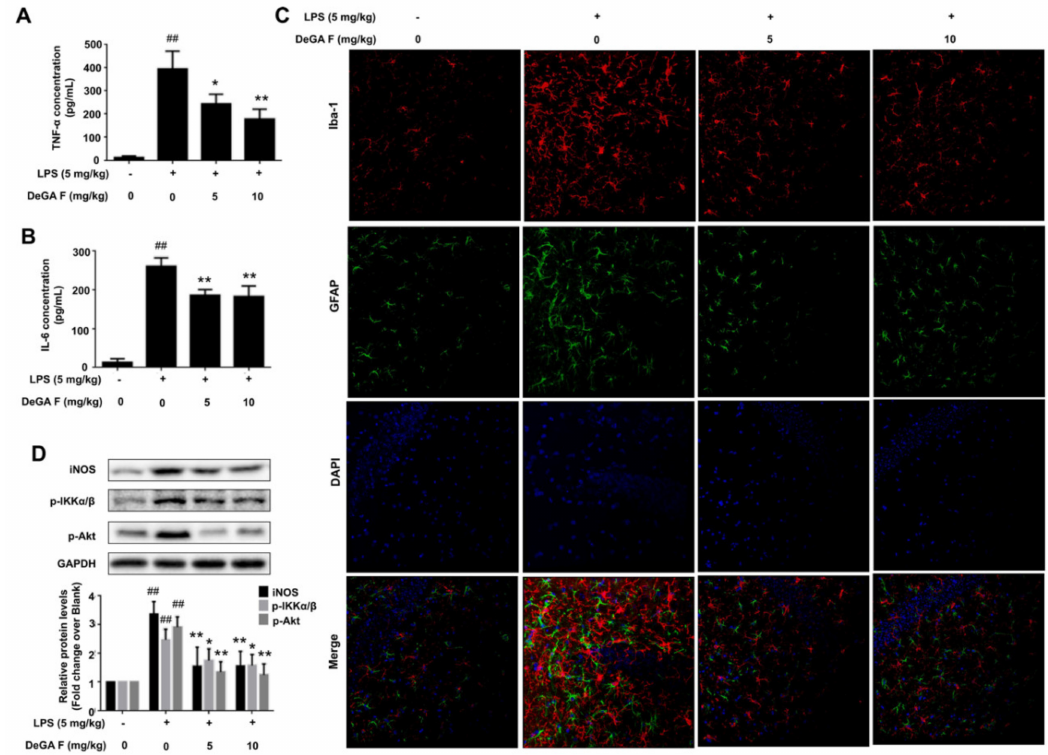
Figure 5. DeGA F attenuated LPS-triggered inflammatory response in mice. Mice were daily administrated with DeGA F for five days, and then subjected to LPS (i.p. 5 mg / kg) 2 h later, on the fifth day. The serum levels of TNF- α ( A ) and IL-6 ( B ) were determined by ELISA. ( C ) Immunofluorescence analysis of mice brain tissues (20 µ m). The tissues were stained with rabbit anti-Iba-1 antibody (red) and mouse anti-GFAP antibody (green). The nuclei were stained with DAPI (blue). ( D ) Expression of inflammation related proteins in mice brain were detected by Western blot analysis. # p < 0.05 and ## p < 0.01 compared with blank group ( n = 7). – and + represented the absence or presence of LPS (5 mg / kg), respectively. * p < 0.05 and ** p < 0.01 compared with the LPS group ( n =